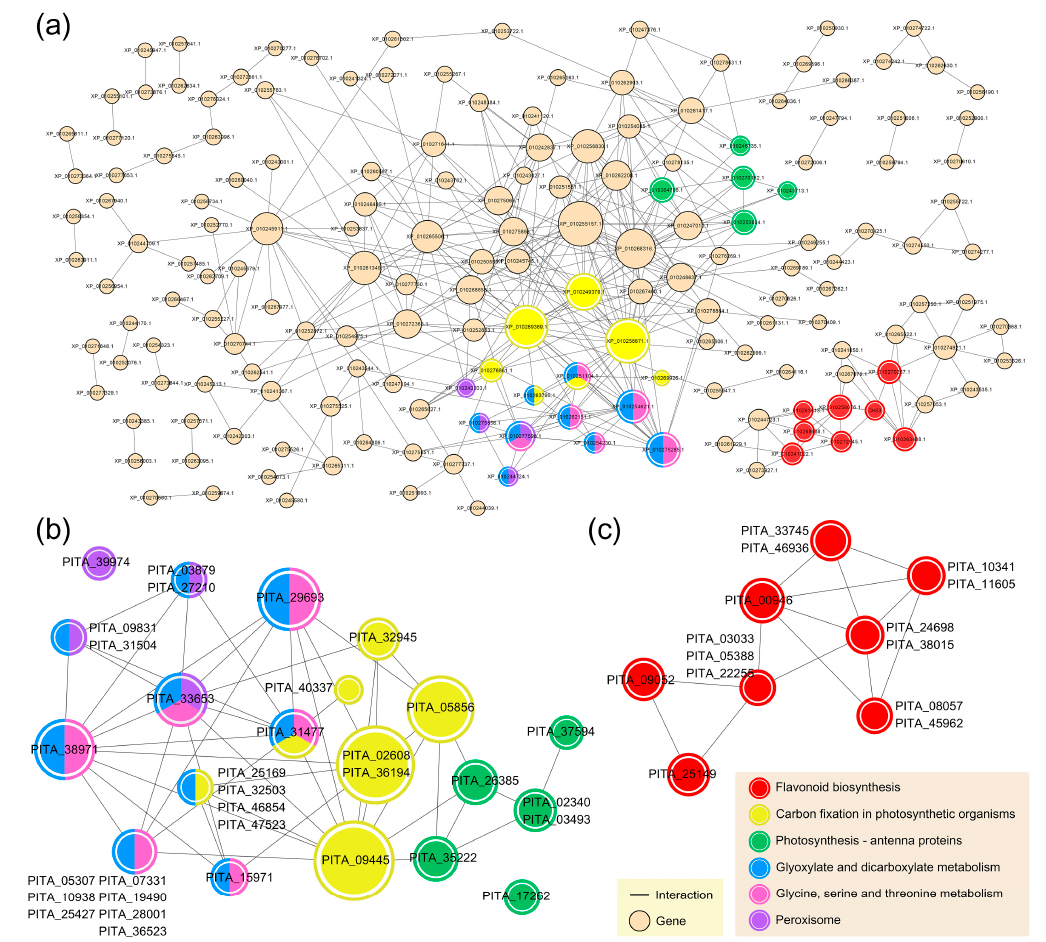
Figure 4. A network of co-expression patterns based on protein–protein interactions. ( a ) The overall networkstructurewithpathwayinformation. Fortheco-expressionpatterns, protein–proteininteraction information was collected using Search Tool for the Retrieval of Interacting Genes / Proteins (STRING) v11 and visualised using the Cytoscape tool. A total of 650 upregulated DEGs were used, with interactions showing a combined score of less than 0.5 being filtered out, resulting in 175 nodes and 386 edges. The diameter of the node reflects the number of direct connections to other nodes. Within nodes, KEGG pathways are indicated by di ff erent colours (identified in the accompanying key). If genes are associated with more than two KEGG categories, the nodes are divided into the corresponding colours. Two groups of densely connected pathways are displayed as subnetworks. ( b ) Carbon fixation in photosynthetic organisms; photosynthesis-antenna proteins; glyoxylate and dicarboxylate metabolism; glycine, serine, and threonine metabolism; peroxisome. ( c ) Flavonoid